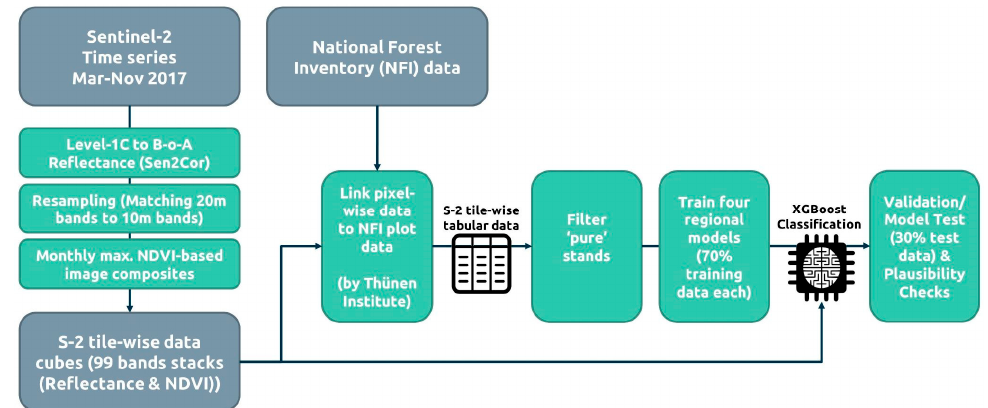
Figure 2. Schematic representation of the workflow.